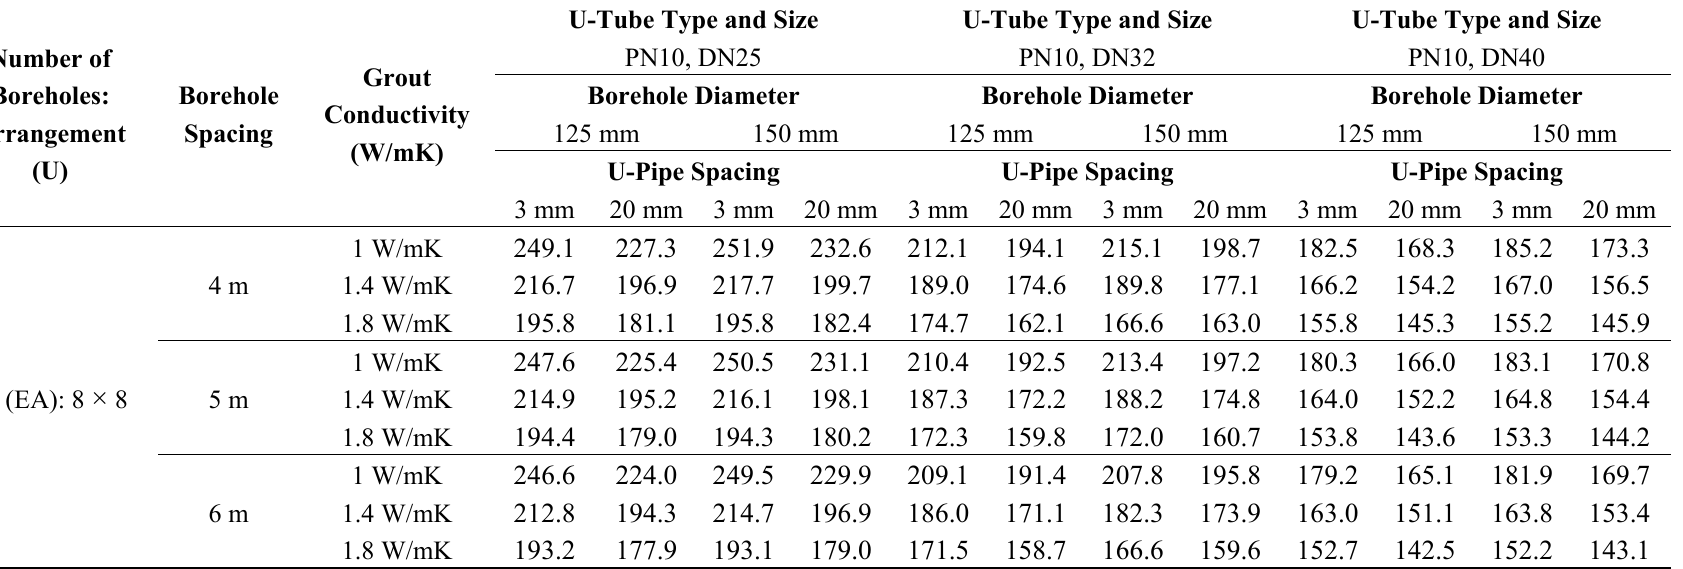
Table 3. Scenarios (length of borehole) of ground heat exchanger (GHE) taking into consideration (entering water temperature) EWT (23 °C) and characteristics of borehole.